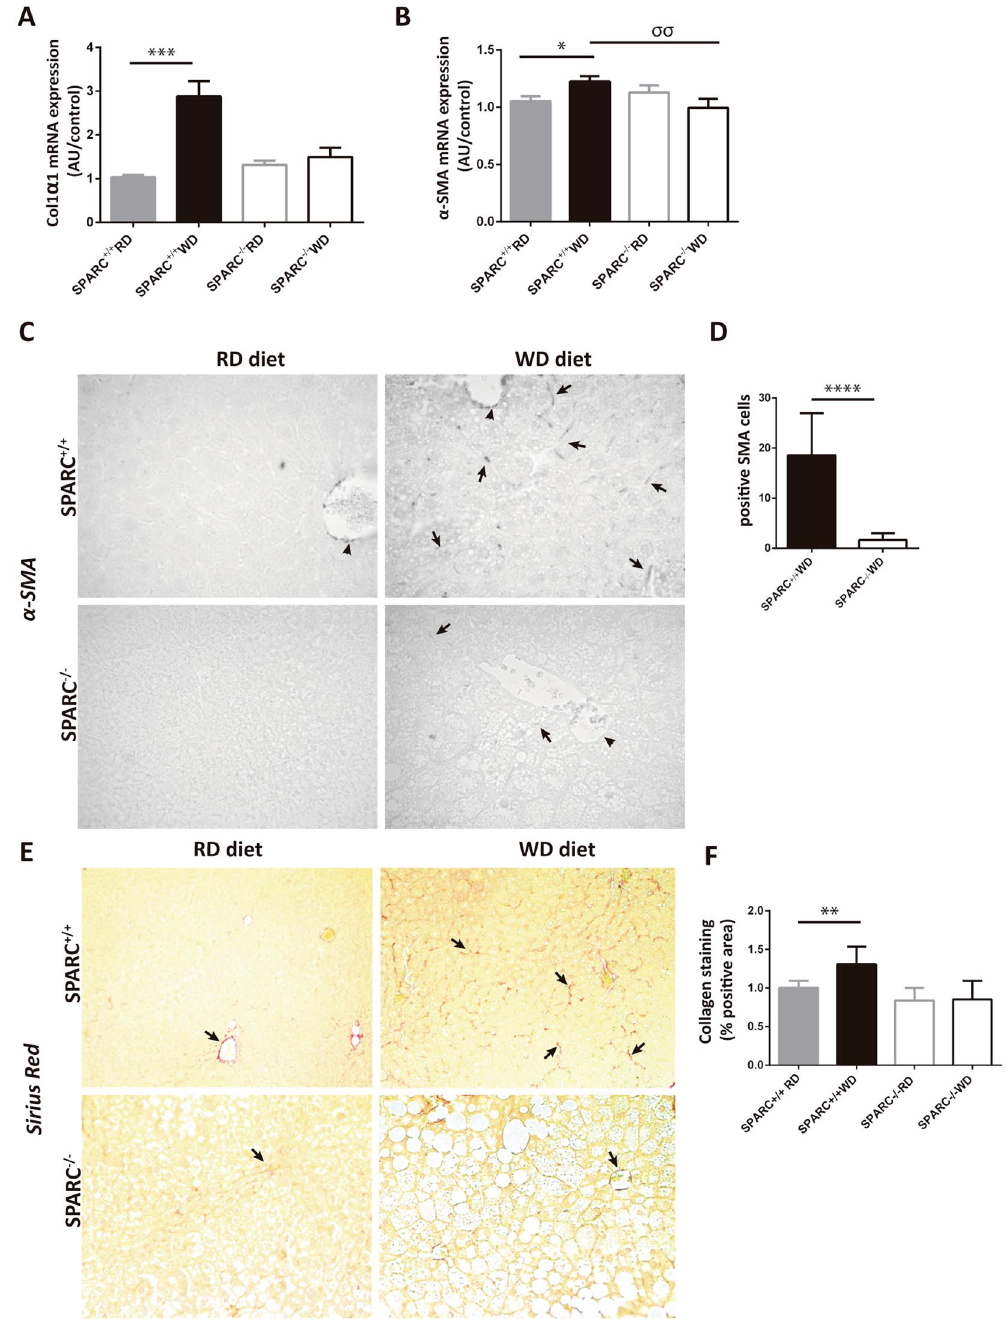
Figure 6. Fibrosis markers decrease in SPARC − / − mice fed with WD diet. ( A , B ) Hepatic expression of collagen alpha I, and α -SMA in response to WD feeding compared with controls. * p < 0.05, *** p < 0.001; σσ p < 0.01; Kruskal-Wallis test with Dunn’s post test. n = 6–8 mice per group. ( C ) Immunohistochemistry for hepatic α -SMA. Arrowheads indicate the internal positive control-stained area (portal myofibroblast). Arrows indicate α -SMA positive cells in the perisinusoidal zone. ( D ) α -SMA positive cells quantification. n = 6 mice per group. Twenty random fields were analyzed for each group (x400 magnification) *** p < 0.001, Mann-Whitney U test. ( E ) Representative images of Sirius red staining of liver sections from SPARC + / + and SPARC − / − mice after feeding WD diet. Arrows indicate collagen deposition. Magnification: 200 × B. ( F ) Quantification of Sirius red- positive areas using image analysis. n = 6–8 mice per group. ** p < 0.01, Kruskal-Wallis test with Dunn’s post